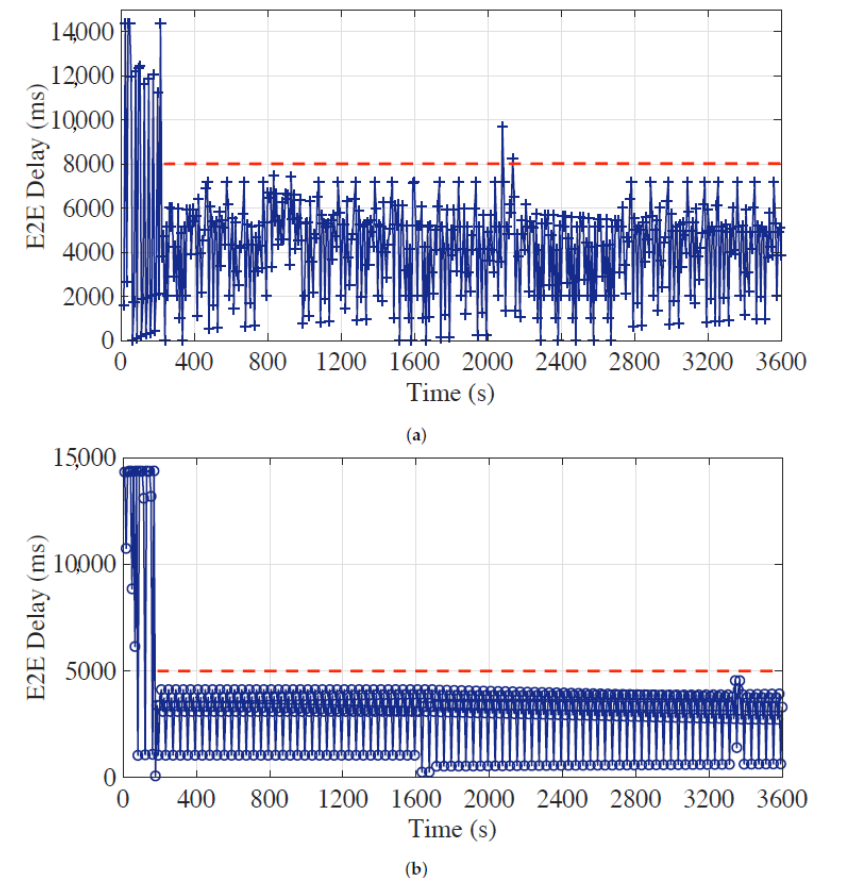
Figure 7. End-to-end (E2E) delay performance of the optimal bundling under static E2E delay requirement setting of ( a ) 8s and ( b ) 5s with the maximum bundling number of 15.